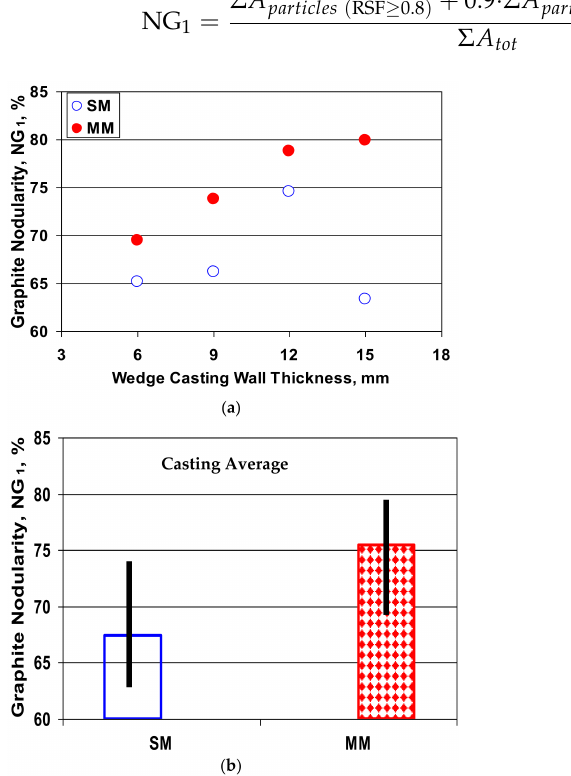
Figure 12. Influence of the mold type and the wedge casting section size on the graphite nodularity NG 1 ( a ) and the average values on the 6–15 mm section size ( b